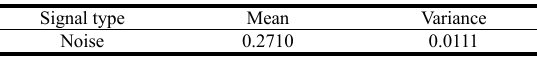
Fig. 5 Noise signals: (a) signal I and (b) signal Q. Table 2: Statistic on noise.